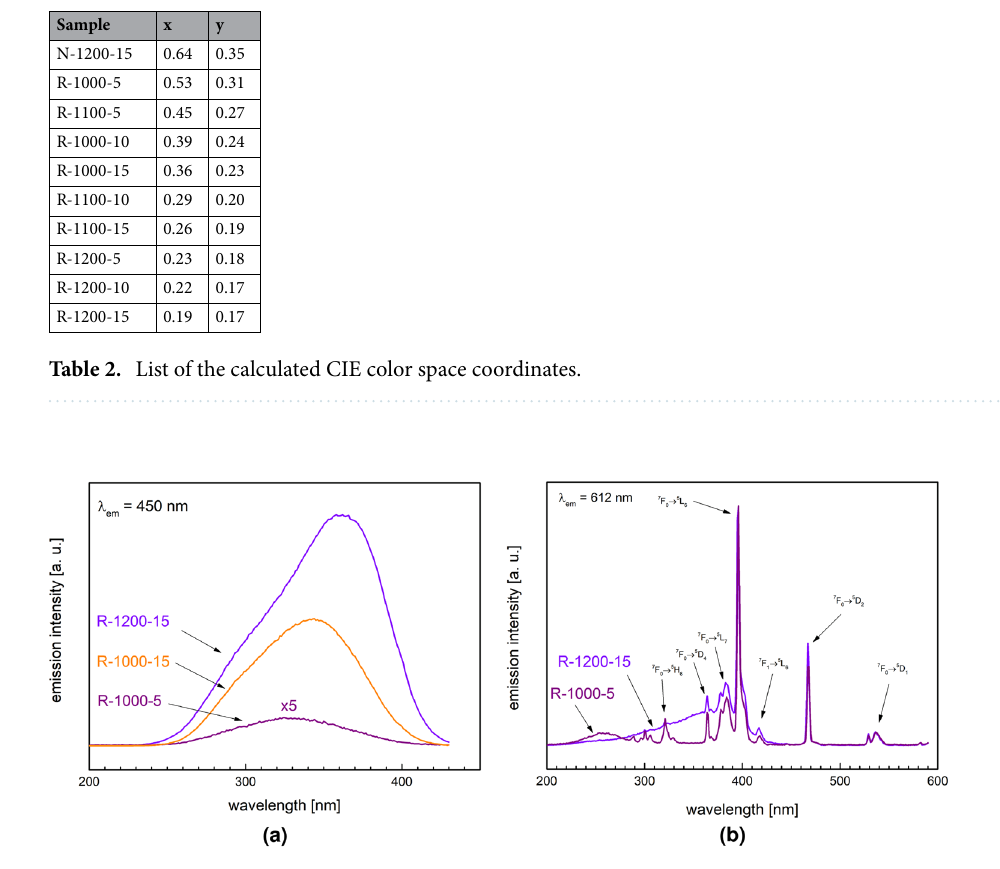
Figure 5. PLE spectra of selected samples: ( a ) for (cid:31) em = 450 nm, ( b ) (cid:31) em = 612